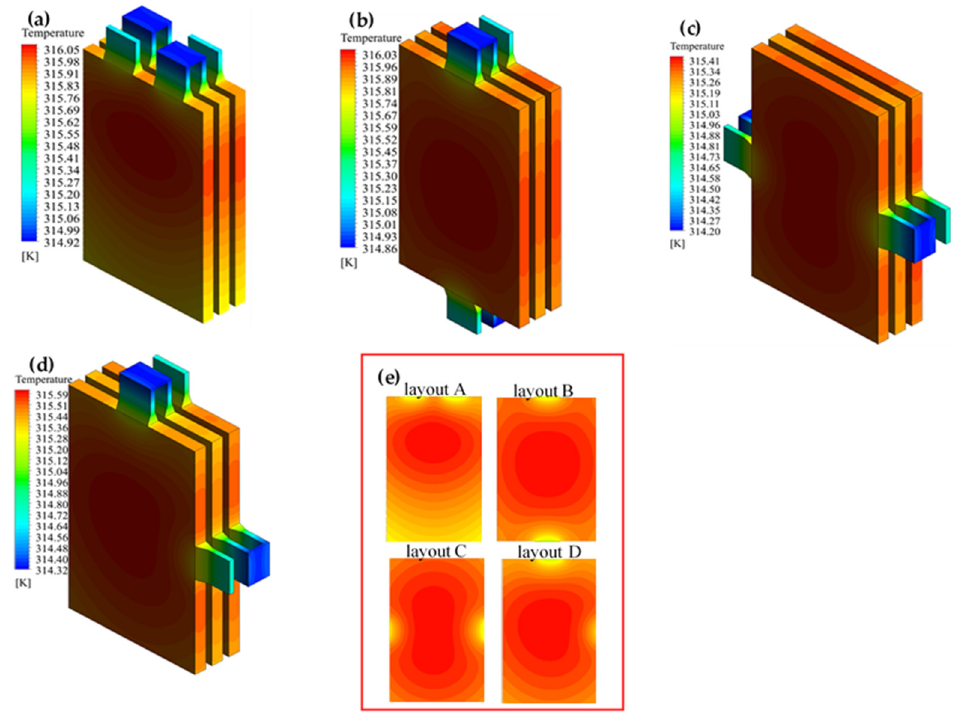
Figure 3. Temperature distribution of different terminal layouts: ( a – d ); ( e ) shows the internal cross-section view of each layout.